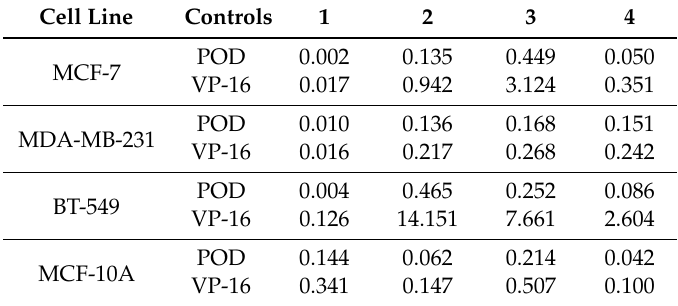
Table 2. Potency of compounds ( 1 – 4 ) compared to controls (POD and VP-16).